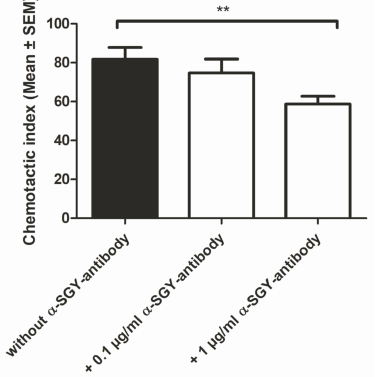
Figure 9. Chemotactic response of 150 nM CCL26 towards eosinophils preincubated with anti ‐ serglycin antibody in three different concentrations compared to non ‐ treated cells; ** p < 0.01 was considered statistically significant; n.s., non ‐ significant.